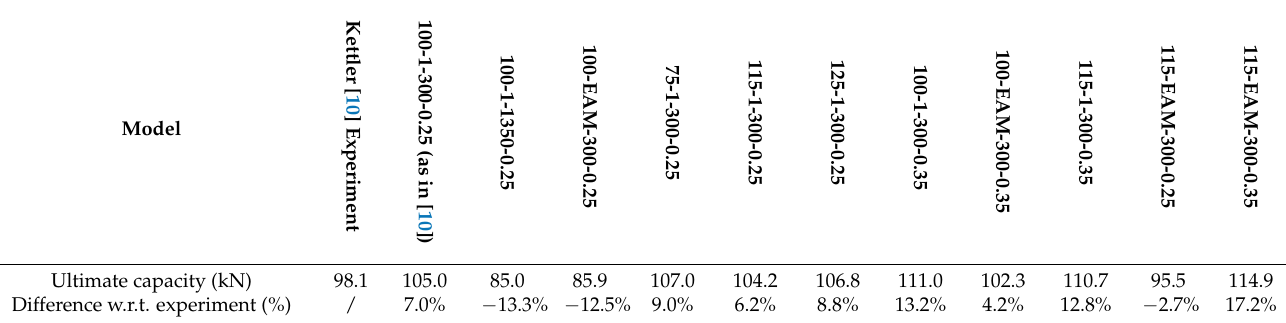
Figure 7. Axial force–displacement curves of the FE models described in Table 2, compared to the experiment [10]: ( a ) imperfection type sensitivity; ( b ) bolt force sensitivity; ( c ) friction coefficient sensitivity with bolt force 100%; ( d ) friction coefficient sensitivity with bolt force 115%. Table 3. Ultimate load capacity comparison to the experimental results